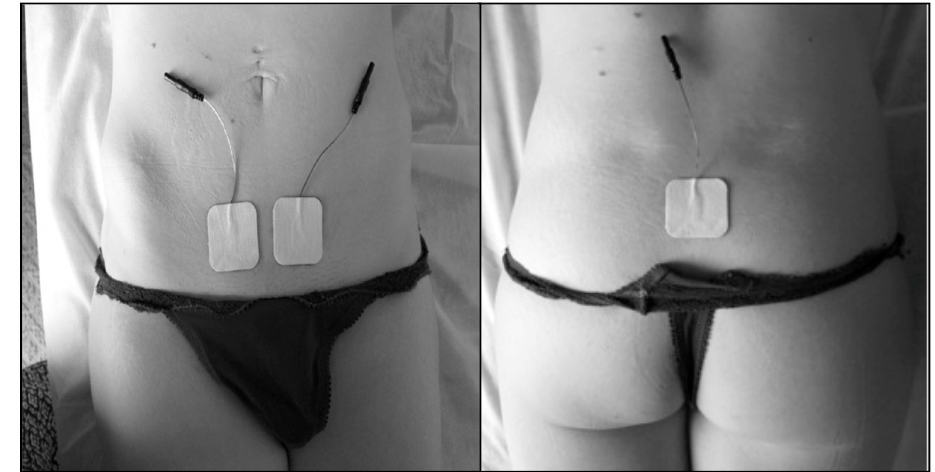
Figure 2. Electrode placement at the abdominal and sacral levels (source: author’s photograph).